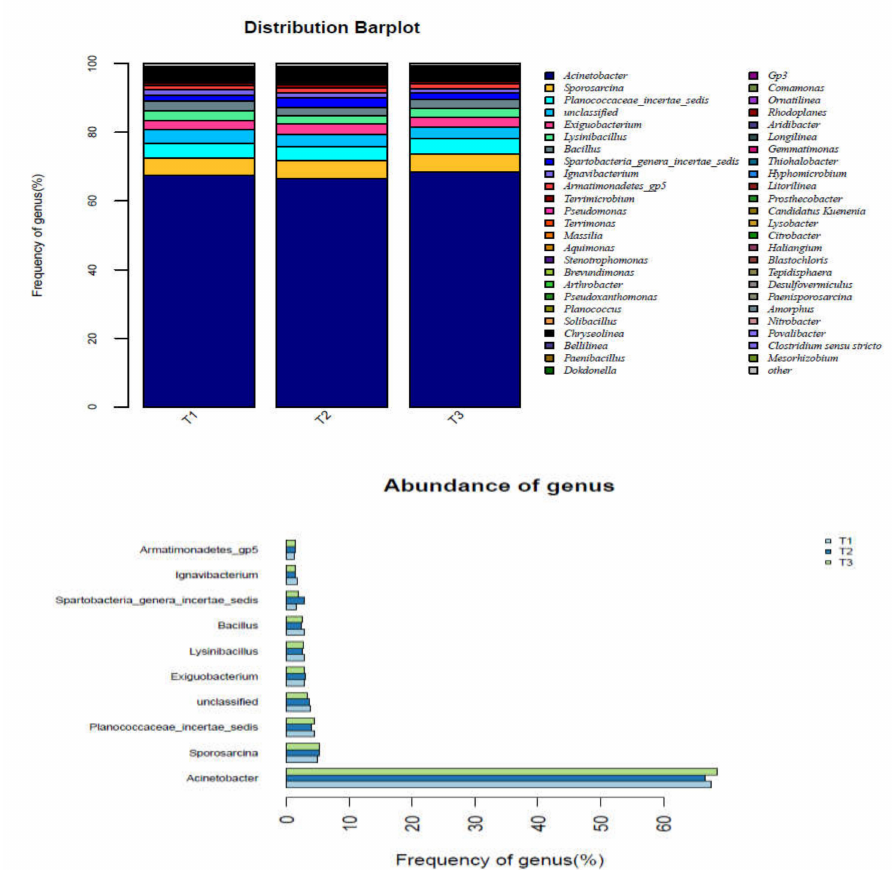
Figure 8. Distribution of microbial community